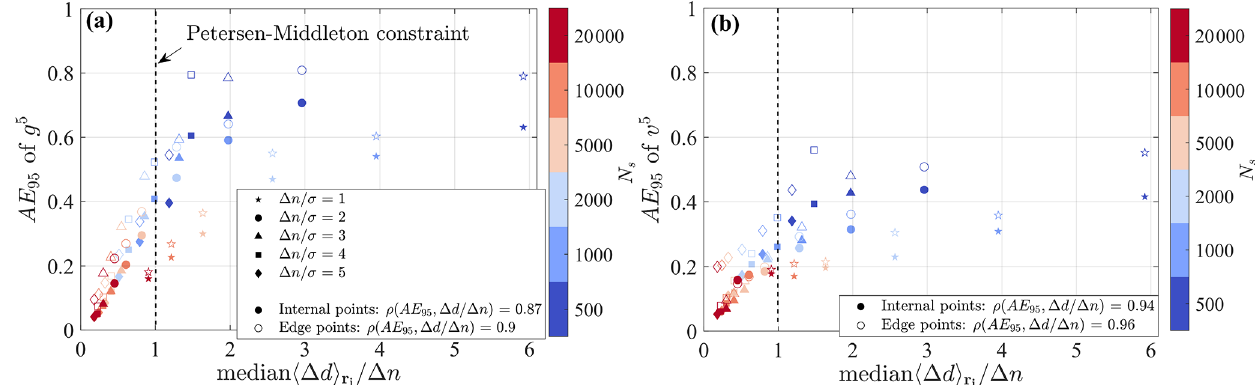
Figure 4. AE 95 as a function of the random data spacing (Eq. 7) for the case with m = 5, N = 20000, and L = 200. (a) Error on the mean and (b) error on the variance. The full symbols refer to points not affected by the presence of the finite boundaries of the domain, while the empty symbols are taken within a distance of less than R max from the